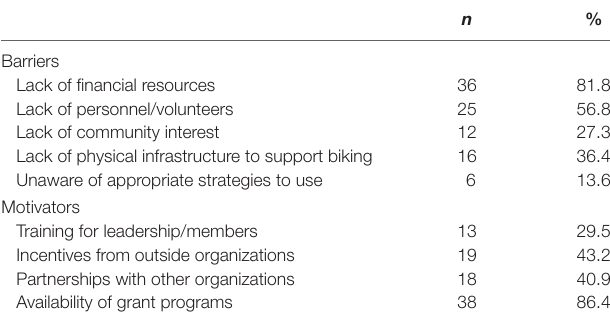
TaBle 3 | Coalition perceived barriers and motivators for programming ( n =